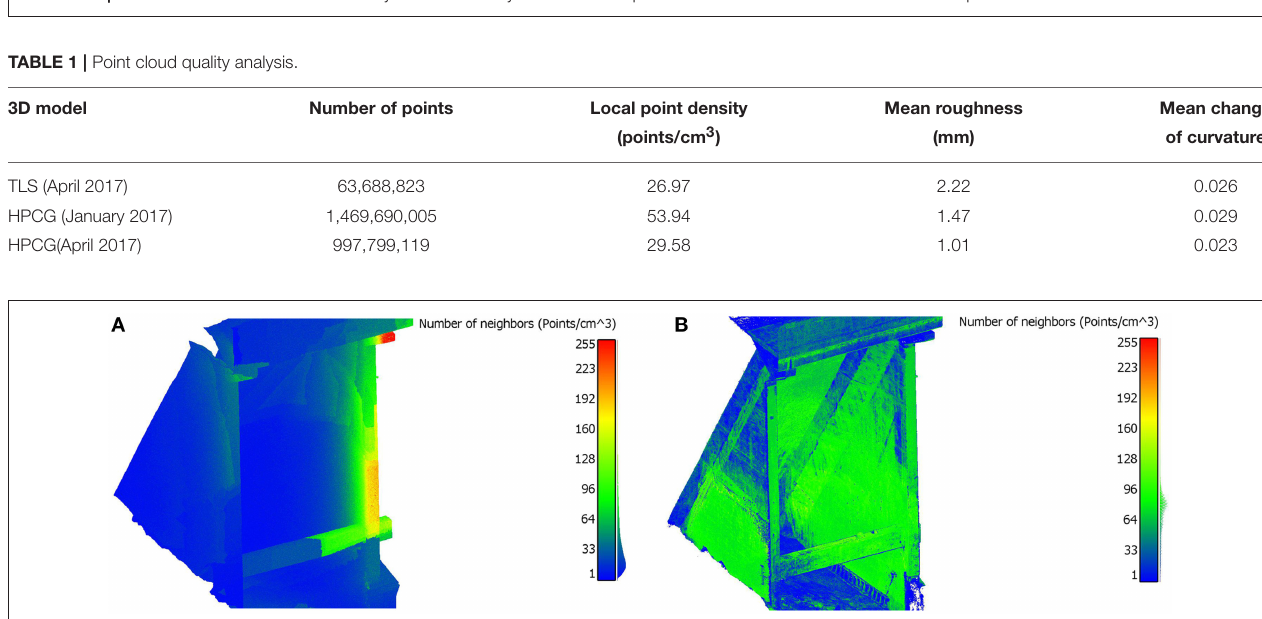
FIGURE 8 | Illustration of the three dimensionality features for Bay#5. Color bar represents the normalized value of each descriptor.